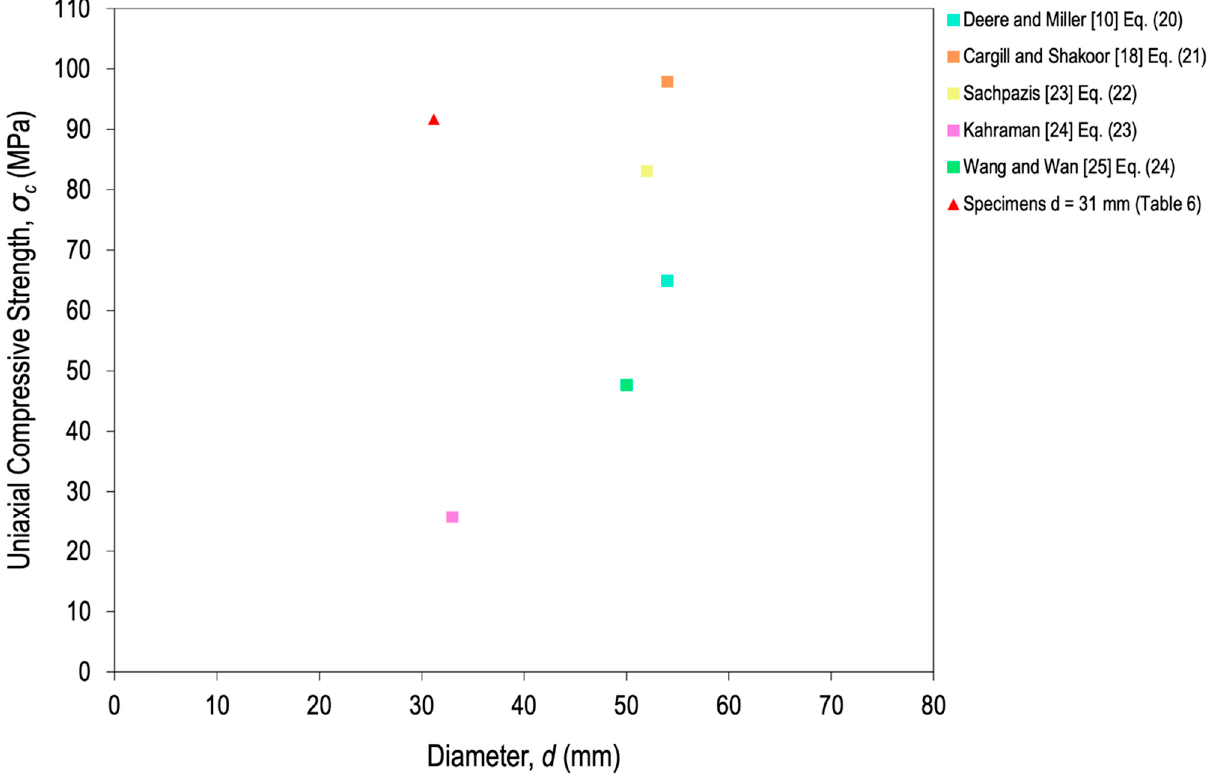
Figure 10. Estimation of σ c from the correlations with R N and R L in Table 2 for travertine.